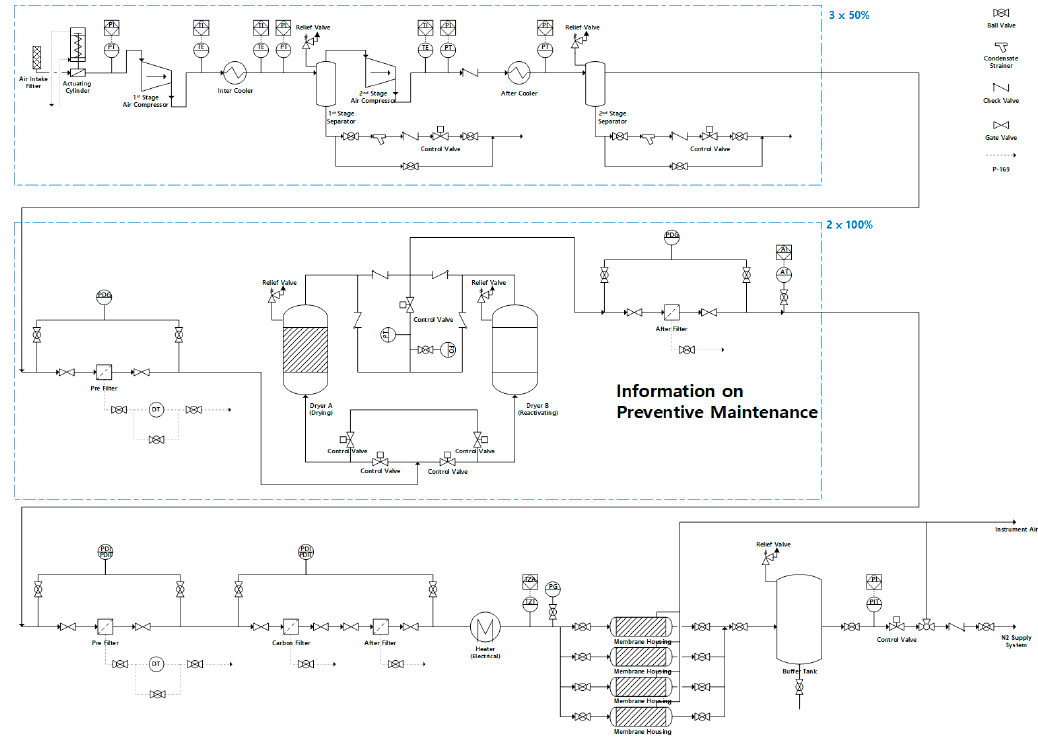
Figure 5. P&ID of air and nitrogen system with information on preventive